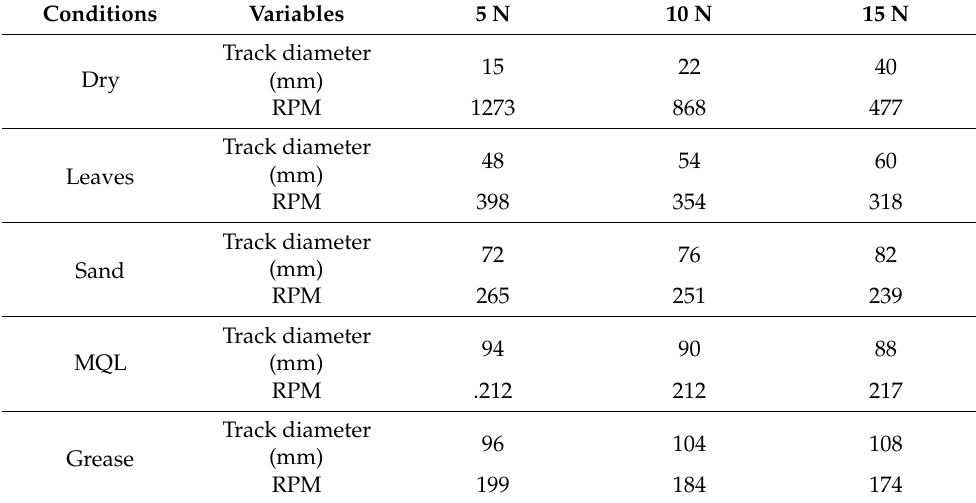
Table 6. Wear track diameter, RPM variation as per the different